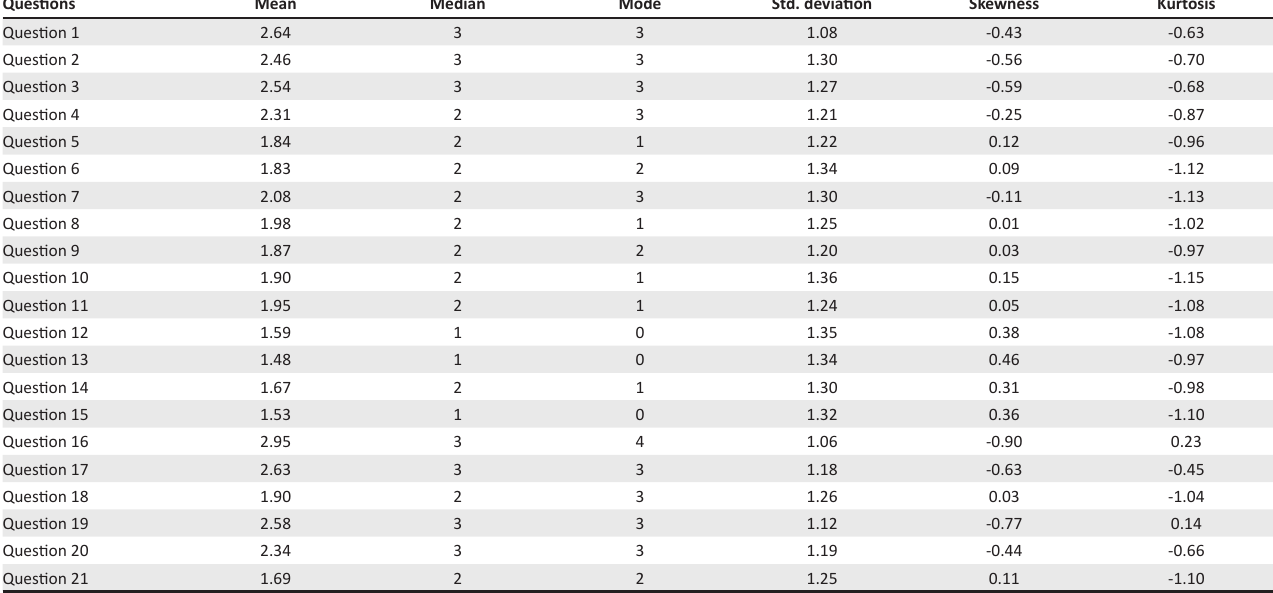
TABLE 3: Descriptive statistics of the leadership style sub-factors. Questions